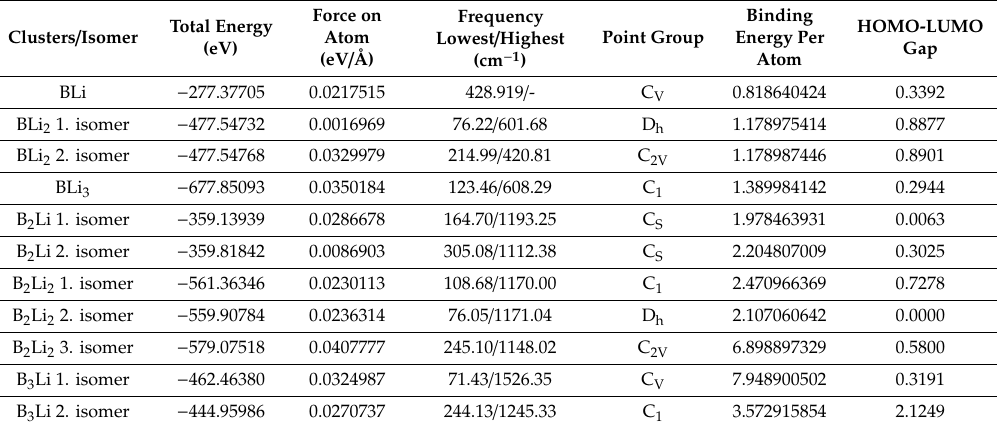
Table 2. Properties of the B x Li y